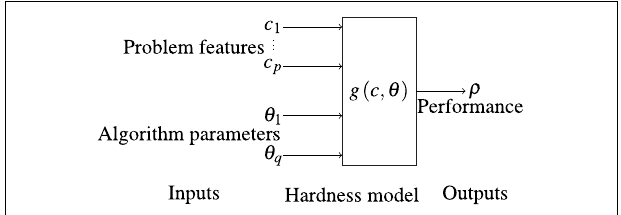
FIGURE 10 | Prediction model 1 . It predicts the algorithm performance based on the problem features c i , 1 (cid:20) i (cid:20) p and the possible algorithm parameters (cid:18) j , 1 (cid:20) j (cid:20) q